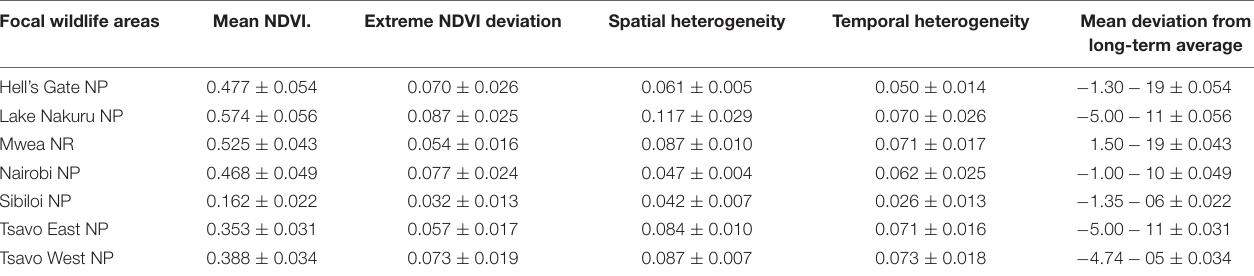
TABLE 4 | Average values of NDVI metrics across focal wildlife areas (NP, National Park; NR, National Reserve) in Kenya from 2000–2019. Focal wildlife